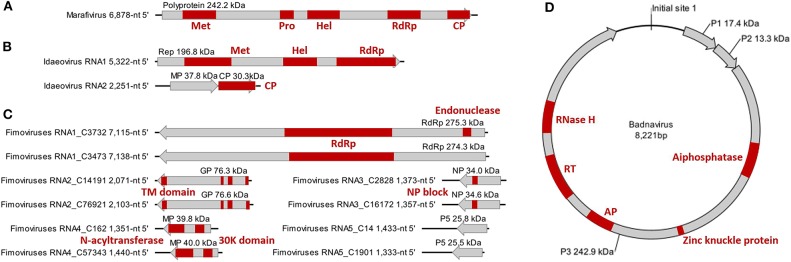
Genome and protein features of Camellia-associated marafivirus (CaMaV) (A) and badnavirus (CaBaV) (D), and Camellia yellow ringspot virus (CaYRSV, the idaeovirus) (B) and chlorotic ringspot viruses (CaCRSVs, the fimoviruses) (C), with conserved aa domains or motifs indicated by red boxes. Met, methyltransferase; Pro, protease; Hel, helicase; RdRp, RNA-dependent RNA polymerase; CP, coat protein; Rep, replicase; MP, movement protein; GP, glycoprotein; TM, transmembrane; NP, nucleocapsid protein; AP, aspartate protease; RT, reverse transcriptase; RNase H, ribonuclease H.